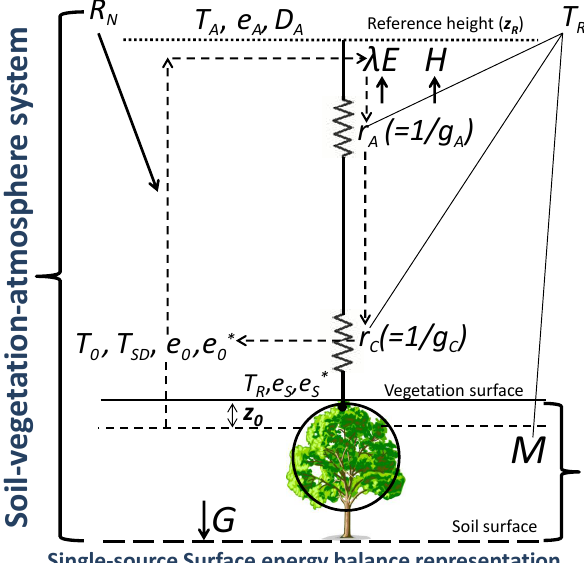
Figure A1. Schematic representation of the one-dimensional de- scription of STIC1.2. In STIC1.2, a feedback is established between the surface-layer evaporative fluxes and source/sink height mixing and coupling, and the connection is shown in dotted arrows between e 0 , e ∗ , g A , g C , and λE . Here, r A and r C are the aerodynamic and 0 canopy (or surface in the case of partial vegetation cover) resis- tances, g A and g C are the aerodynamic and canopy conductances (reciprocal of resistances), e ∗ is the saturation vapor pressure of the S surface, e ∗ is the saturation vapor pressure at the source/sink height, 0 T 0 is the source/sink height temperature (i.e., aerodynamic temper- ature) that is responsible for transferring the sensible heat ( H ), e 0 is the source/sink height vapor pressure, e S is the vapor pressure at the surface, z 0 is the roughness length, T R is the radiometric surface temperature, T SD is the source/sink height dew-point temperature, M is the surface moisture availability or evaporation coefficient, R N and G are net radiation and ground heat flux, T A , e A , and D A are temperature, vapor pressure, and vapor pressure deficit at the refer- ence height ( z R ), λE is the latent heat flux, and H is the sensible heat flux,